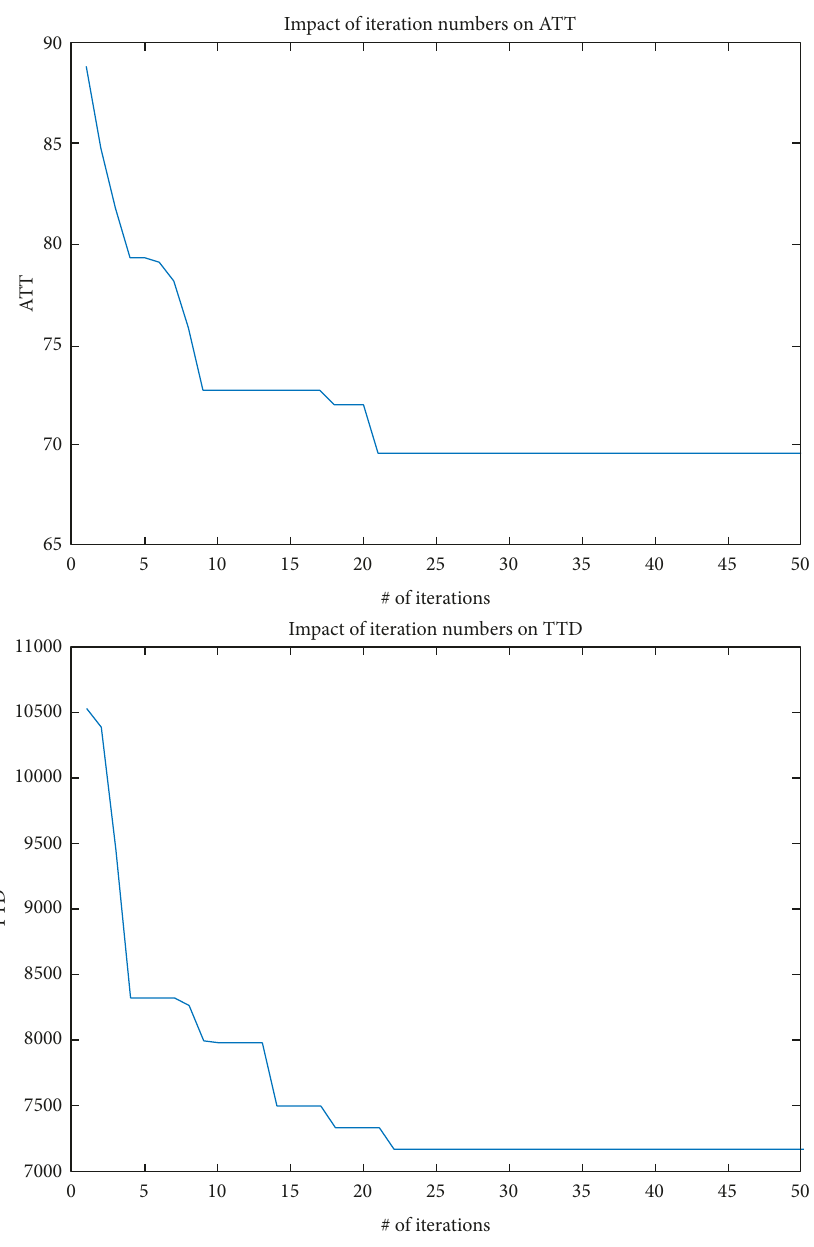
Figure 12: Of iterations on the performance of DSC system. Table 4: Demand profile of scenario